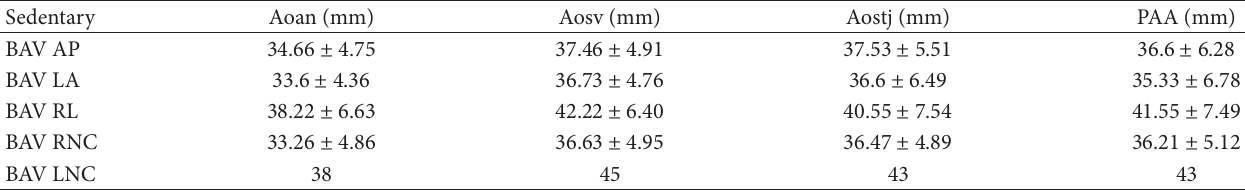
Table 1: Dimensions of the aortic tract in BAV sedentaries with diverse morphological patterns. Sedentary